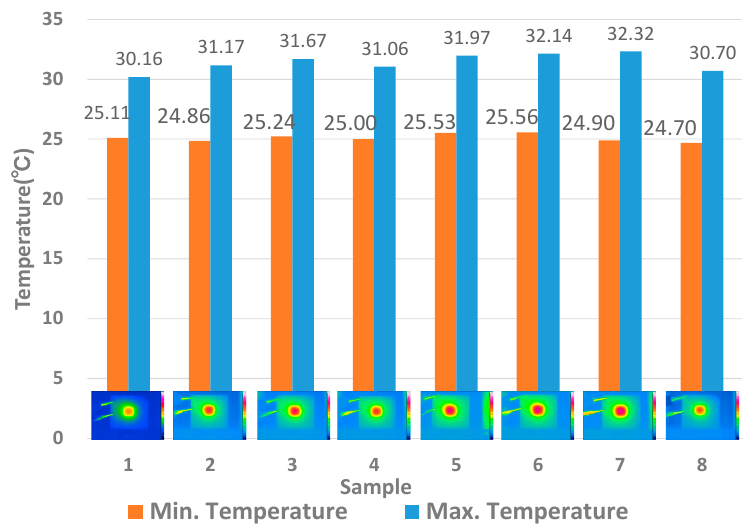
Figure. 5. Measured temperature distributions of each sample. The red region in the temperature map is corresponding to the emission area of each sample with the dimension of 1 cm × 1 cm.